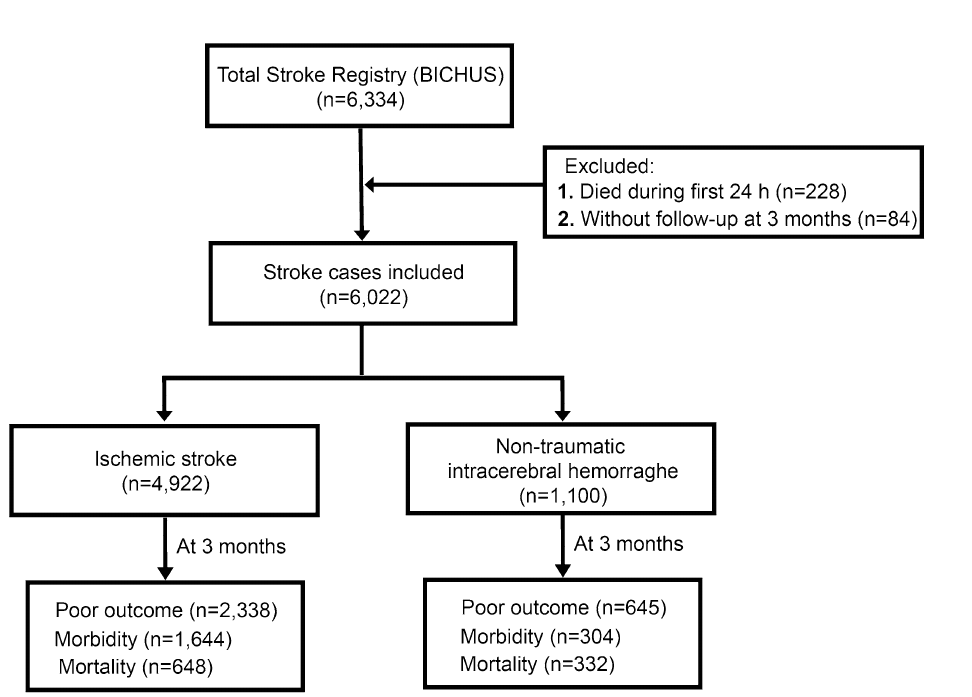
Figure 1. Flowchart of patient groups and functional